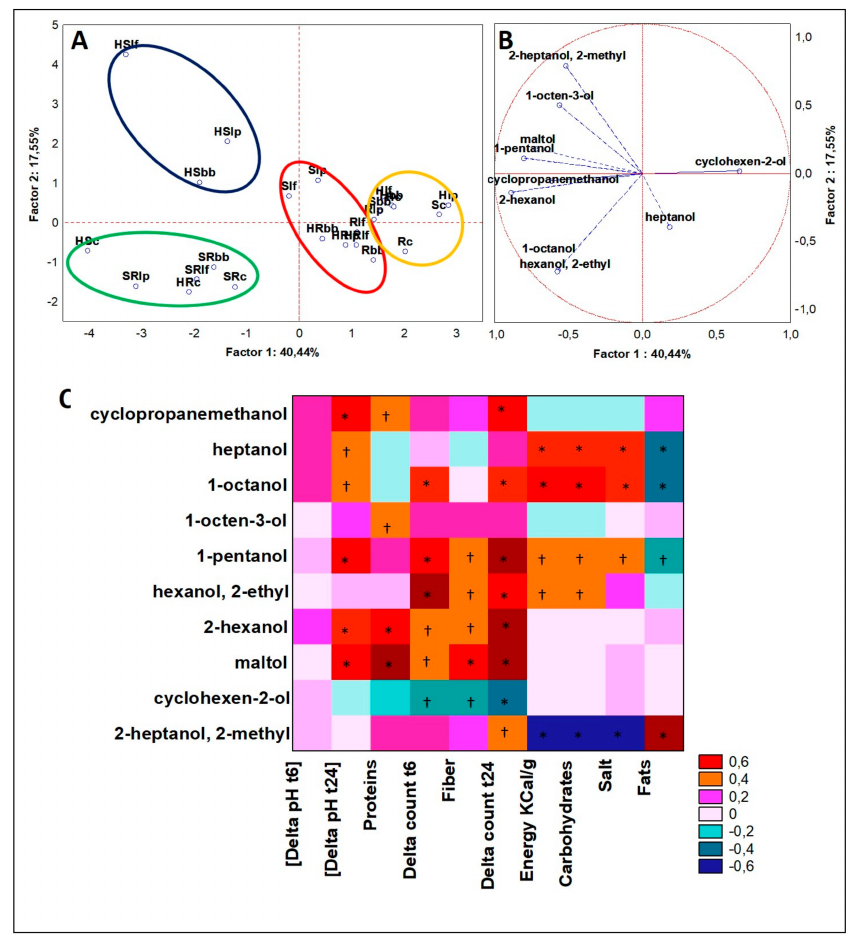
Figure 3. ( A ) Principal Component Analysis (PCA) of cases and ( B ) variables on alcohols; ( C ) Spearman rank correlations on alcohols. * p < 0.01; † p < 0.05. For samples abbreviations see Figure 1. Figure 3A: cluster 1 = blue line; cluster 2 = red line; cluster 3 = green line; cluster 4 = yellow